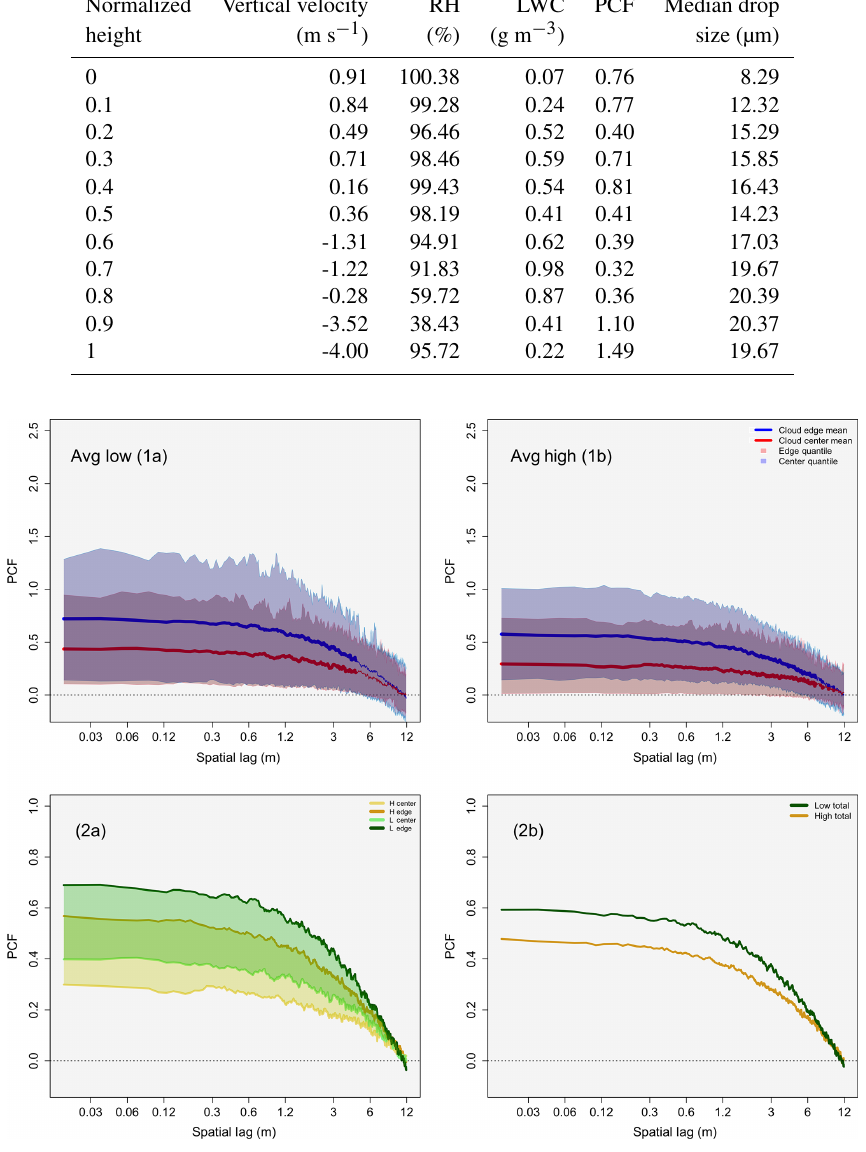
Table 7. Values for vertical velocity (ms − 1 ), RH (%), LWC (gm − 3 ), the PCF, and the median drop size (µm), respectively, for each normalized cloud height in Fig. 8.